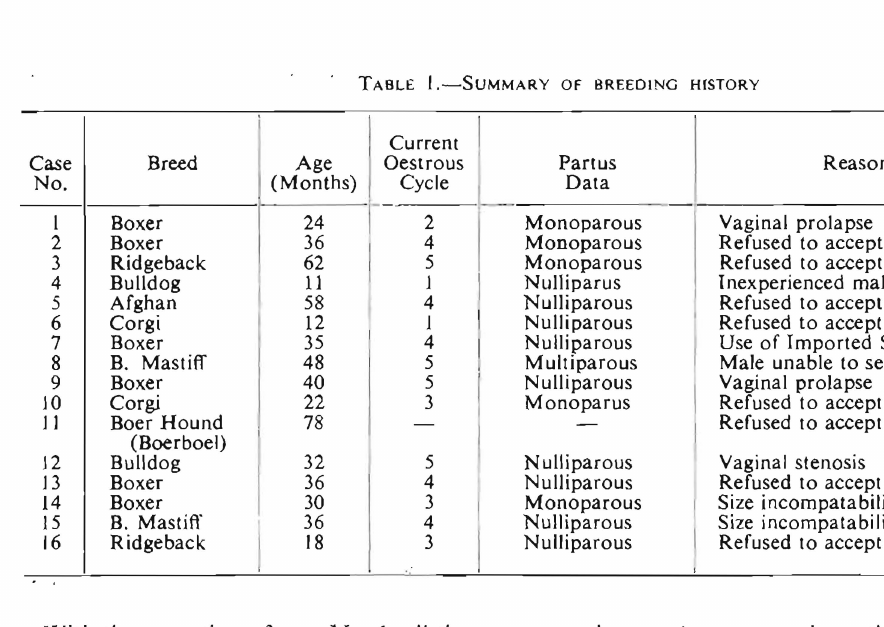
TABLE I.-SUMMARY OF BREEDING HISTORY